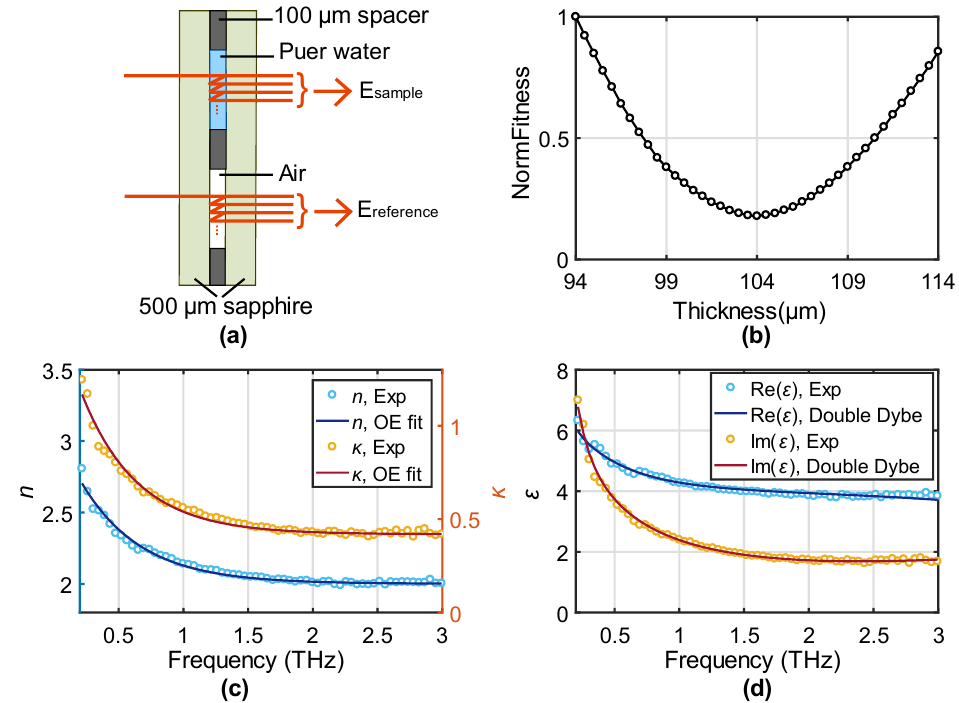
Figure 4. ( a ) Schematic of the water thin film measurement. ( b ) NormFitness as a function of thickness ranging for 94–114 µ m. ( c ) n and κ of water extracted from the optimized thickness (open circles) and the fitting to the OE functions (solid curves). ( d ) Complex permittivity of water at the optimized thickness (open circles) and the fitting to the double-Debye model.